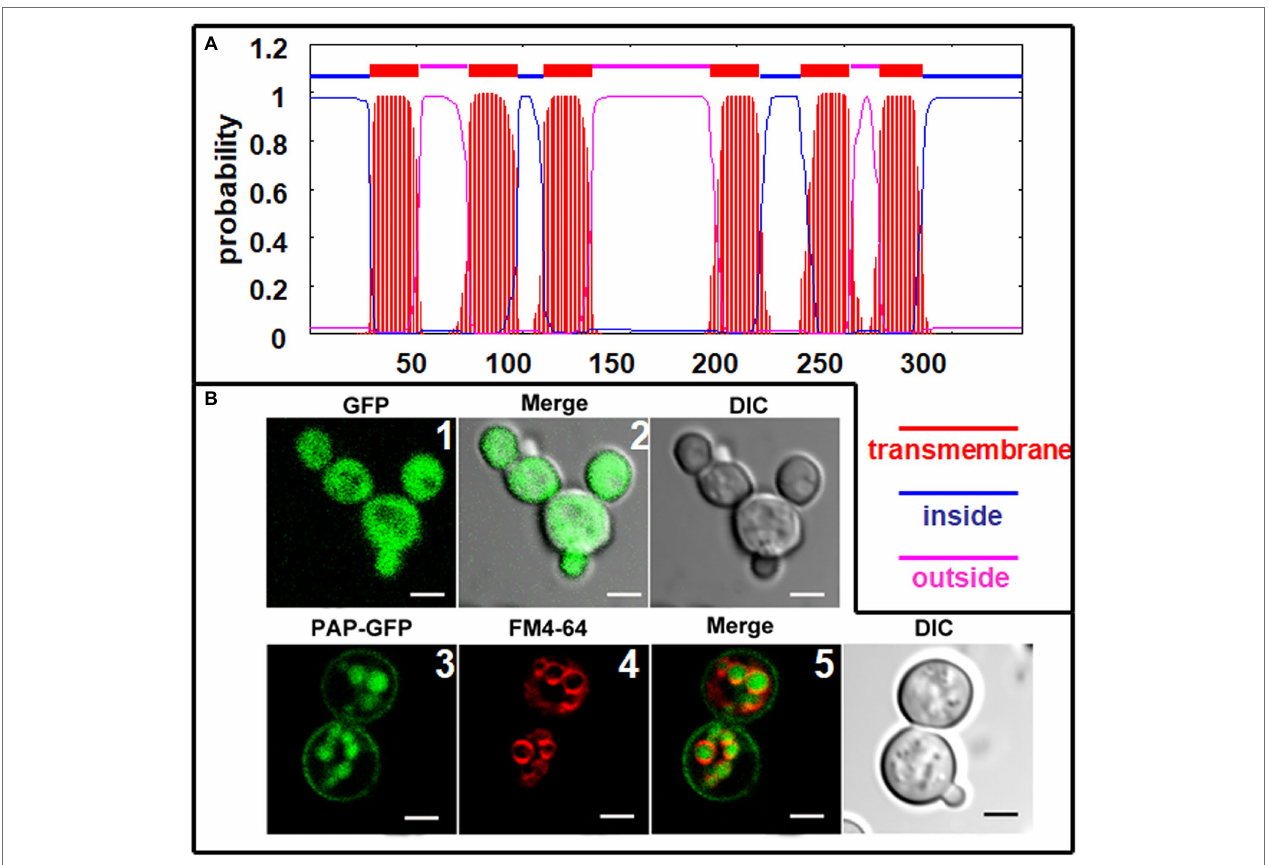
FIGURE 5 | Subcellular localization of ChPAP2 in yeast cells. (A) Transmembrane helices in ChPAP2 (GenBank no. KT750011) were predicted using the TMHMM server v. 2.0; (B) the green fluorescence was observed using a confocal microscope. Upper: GFP gene expressed in the pYES2 vector and in the yeast strain INVSc1. Left, middle, and right panels show fluorescence, merged, and bright-field (DIC) images. Lower: ChPAP2 -EGFP fusion gene expressed in the pYES2 vector and in the yeast strain INVSc1. Live cells overexpressing ChPAP2 -EGFP were incubated with FM4-64. Left, second, third, and right panels show fluorescence, FM4- 64, merged, and bright-field (DIC) images. Bars = 5 μ